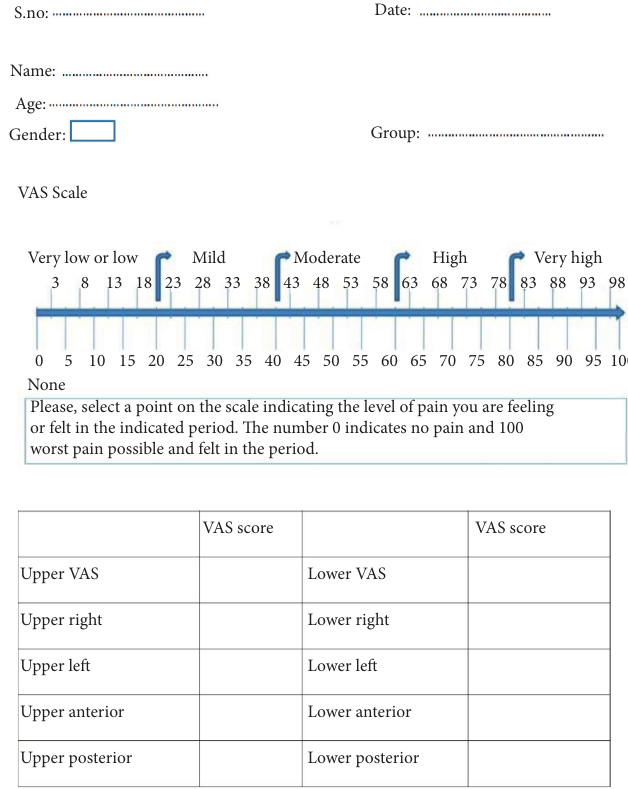
Figure 1: The form used to collect data using the Visual Analog Scale.